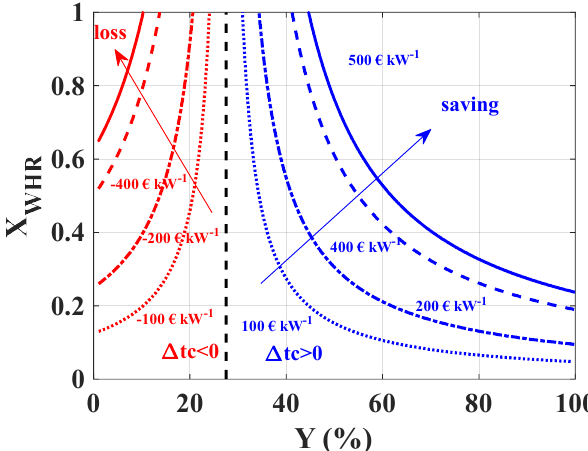
Figure 12. X WHR - Y map developed for the Italian cost of the electric energy, by considering a total operating time of 7 years and a SCOP of the VCC plant equal to 2.5. The curves refer to either specific cost savings (in blue) or losses (in red).